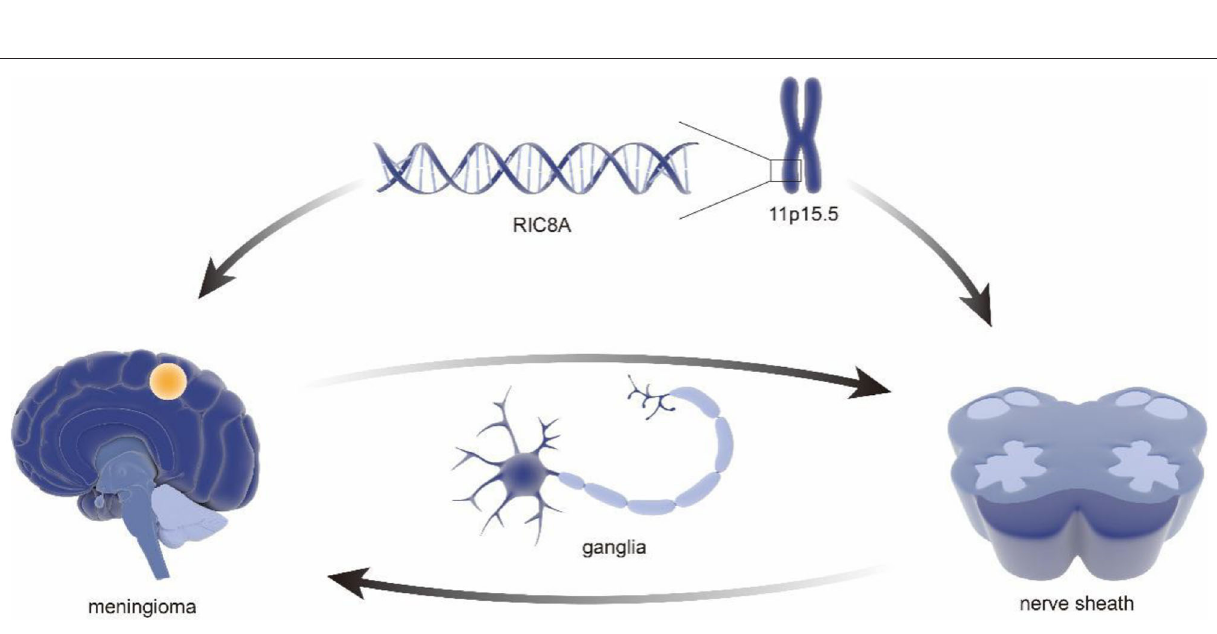
Frontiers in Oncology | www.frontiersin.org